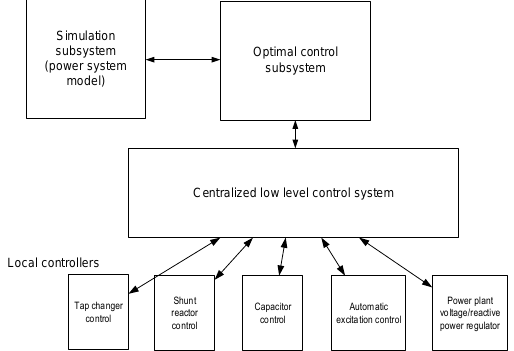
Fig. 2. Structure of the voltage and reactive power control system